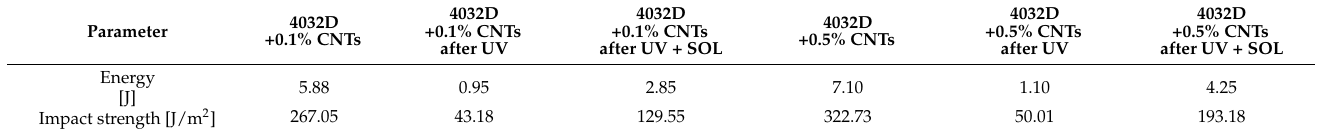
Table 6. Values of energies and impact coefficients for samples 4032D admixed with